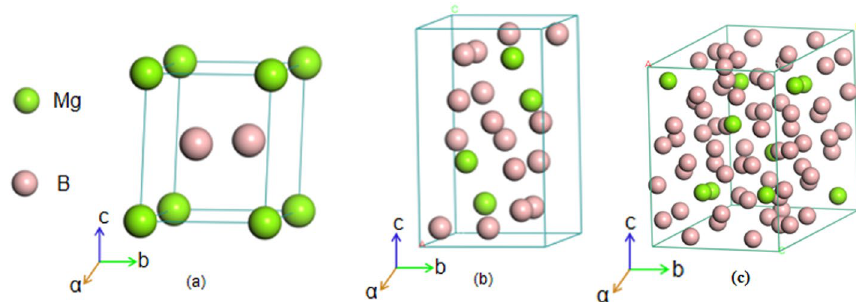
Figure 1. Optimised crystal structures of Mg–B compounds: ( a ) MgB 2 ; ( b ) MgB 4 ; ( c ) MgB 7 .